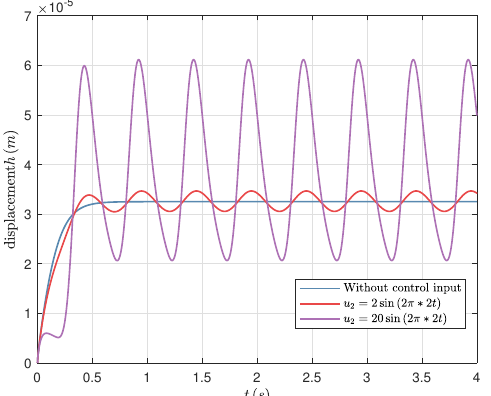
Figure 5. Dynamic responses of hydrostatic bearing compensated with an active membrane restrictor.